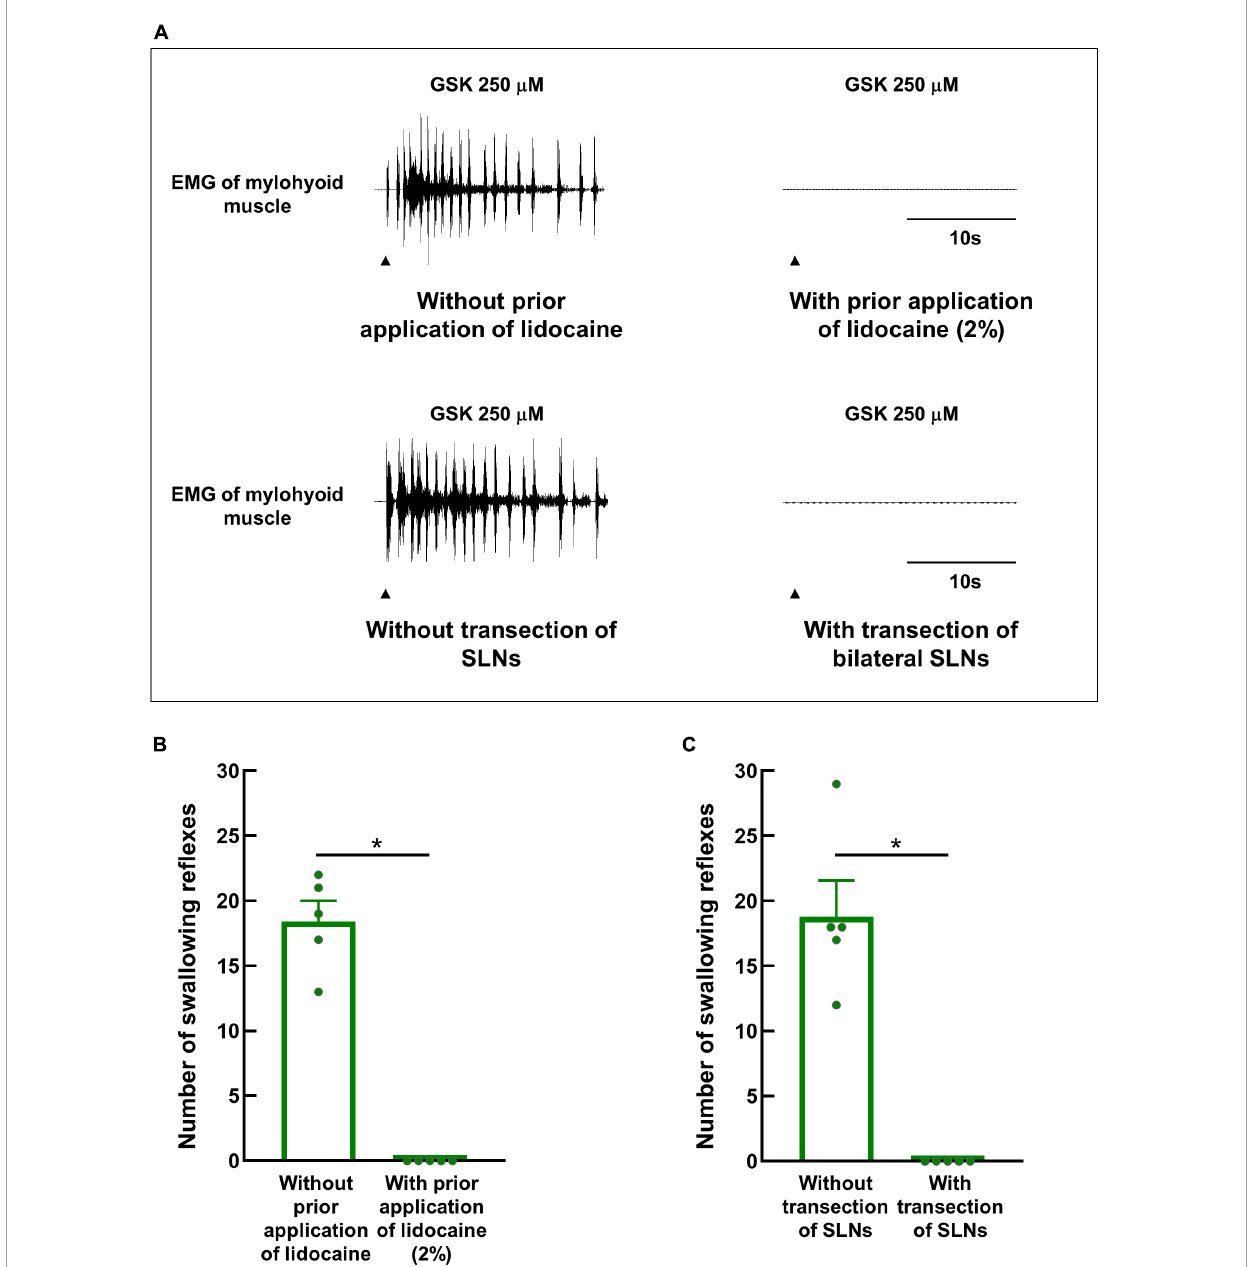
FIGURE6 Prior topical application of lidocaine or bilateral transection of SLNs completely prevented the triggering of GSK1016790A-induced swallowing reflexes. (A) Swallowing reflexes triggered by GSK1016790A 250 µ M with or without prior topical application of lidocaine (2%) or bilateral transection of SLNs. Black arrowheads indicate the onset of stimulating solution delivery. (B) Comparison of the numbers of swallowing reflexes triggered by GSK1016790A 250 µ M with and without prior application of lidocaine. (C) Comparison of the numbers of swallowing reflexes triggered by GSK1016790A 250 µ M with and without prior bilateral transection of SLNs. n = 5. The number of triggered swallowing reflexes was counted for 20 s following application of the stimulating solutions. Data are presented as the mean ± SEM. Circles in the column graph represent individual data points. * P < 0.05 by paired t